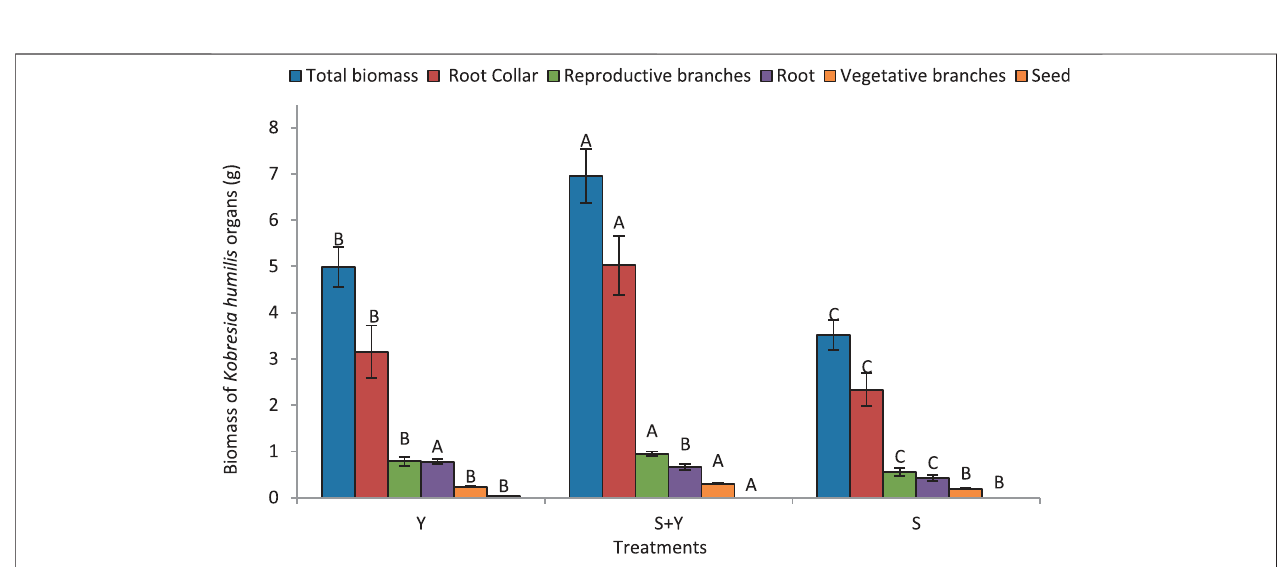
FIGURE4| Effect ofgrazing methods onmaterial partitioning patterns of K.humilis .Capitalletters indicate signi fi cantdifferences inthebiomass ofeach trait under grazing methods ( p < 0.05).